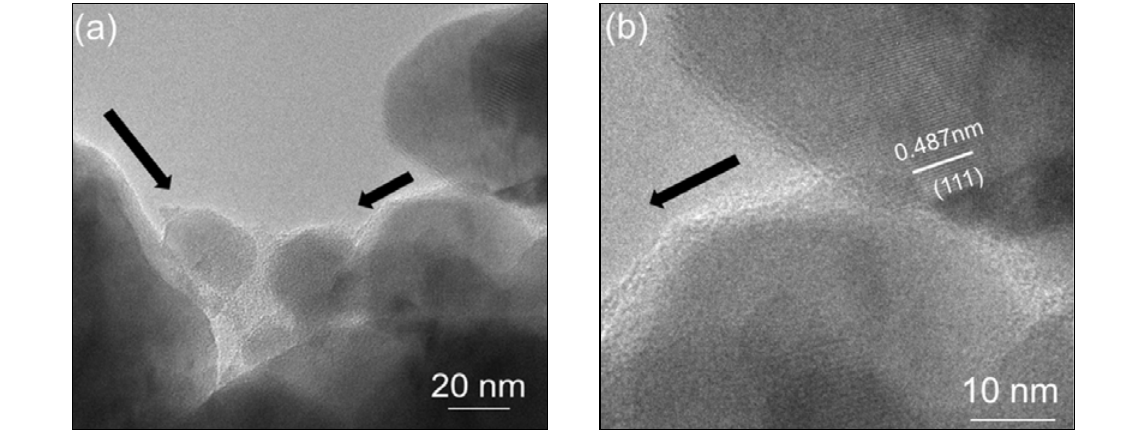
Figure 6. HR-TEM images of the ZnFe